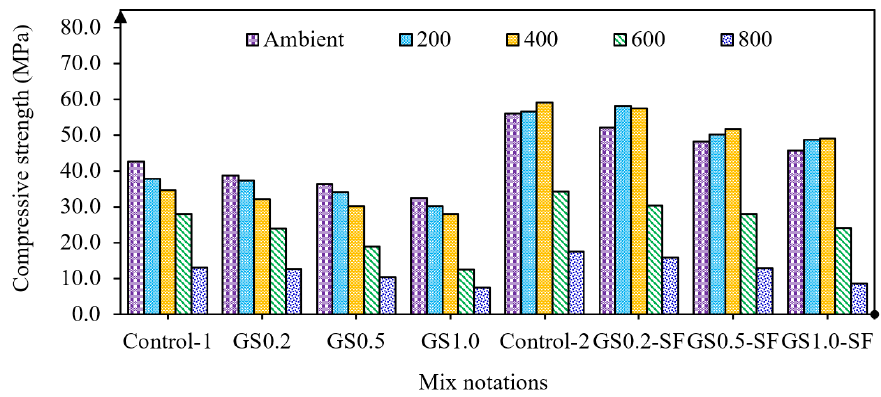
Fig. 5. Compressive strength of CRT concrete after exposure to high temperatures